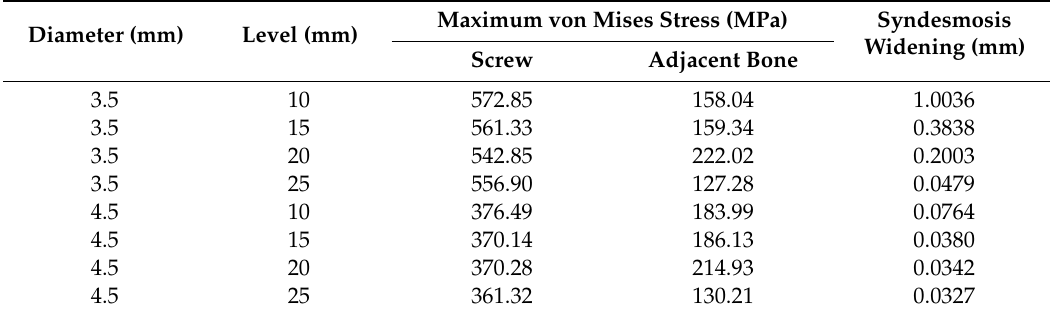
Table 5. Maximum von Mises stresses and syndesmosis widening: titanium screw with three cortical bones purchased.